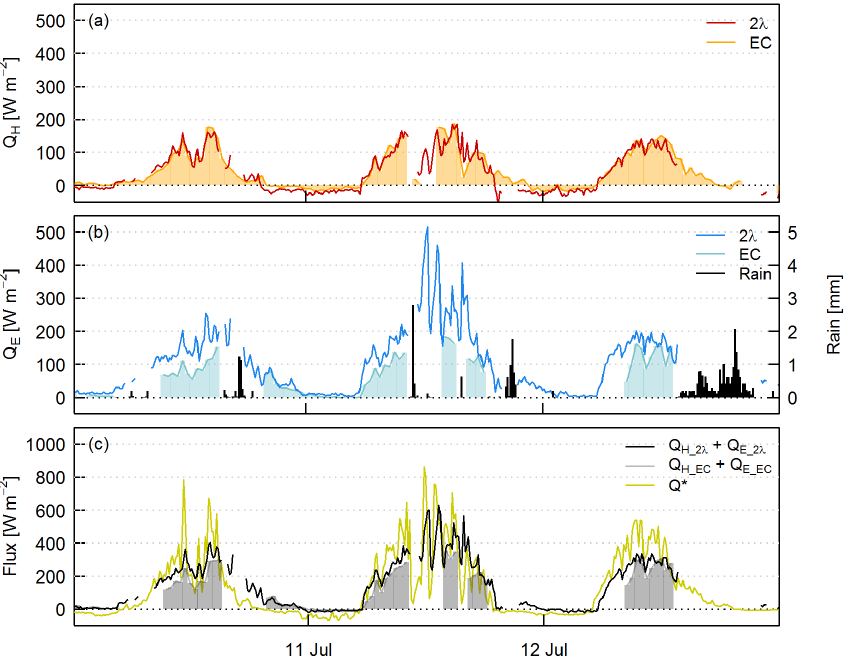
Figure 5. Response of (a) sensible and (b) latent heat fluxes to rainfall (right-hand axis) and (c) net all-wave radiation. Shading indicates availability of EC data. EC data are at 30min intervals; all other data are at 10min